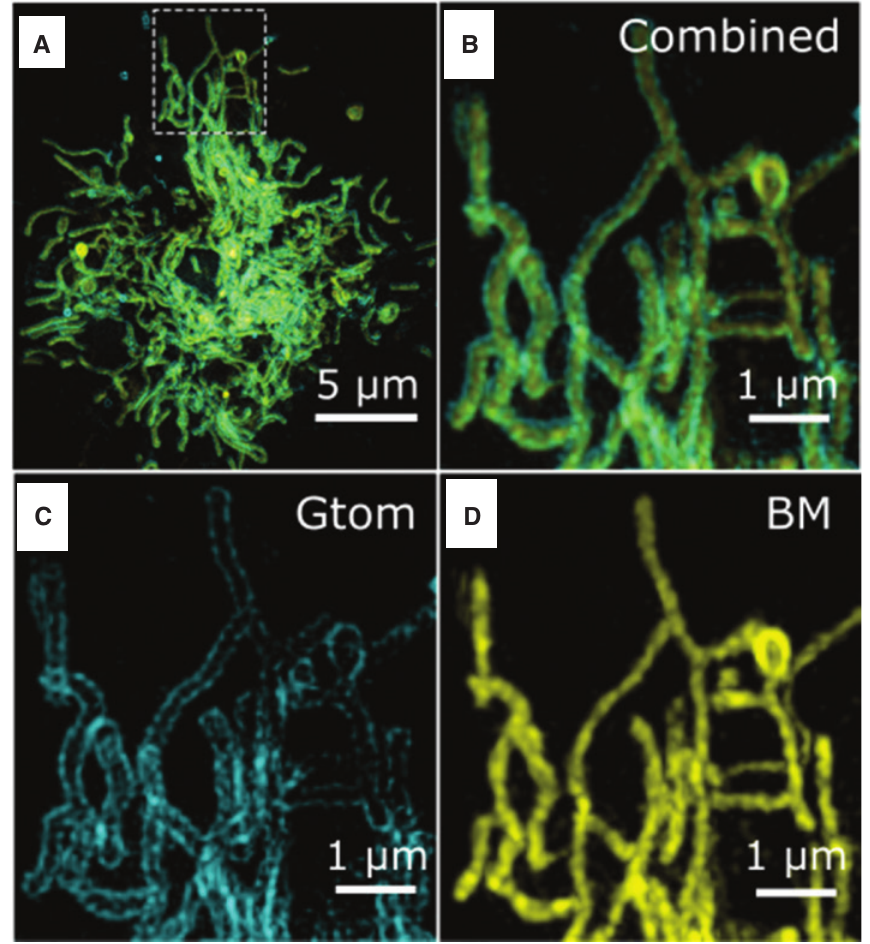
Figure 3: Live imaging of an MCC13 cell dually labeled with Gtom and BM. The boxed region in (A) is shown magnified for the combined (B) and individual probes (C and D). Gtom (C) localizes at the mitochondrial outer membrane, and the BM label (D) localizes in the mitochondrial matrix. Gtom surrounding BM is shown in the merged image (B). Images are maximum intensity projections of a 1.25- μ m 3D SIM